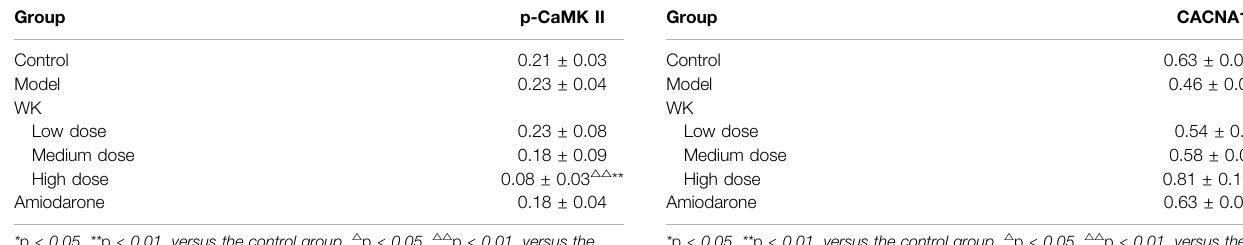
TABLE 7 | The level of CACNA1C ( x ± s , n (cid:1)